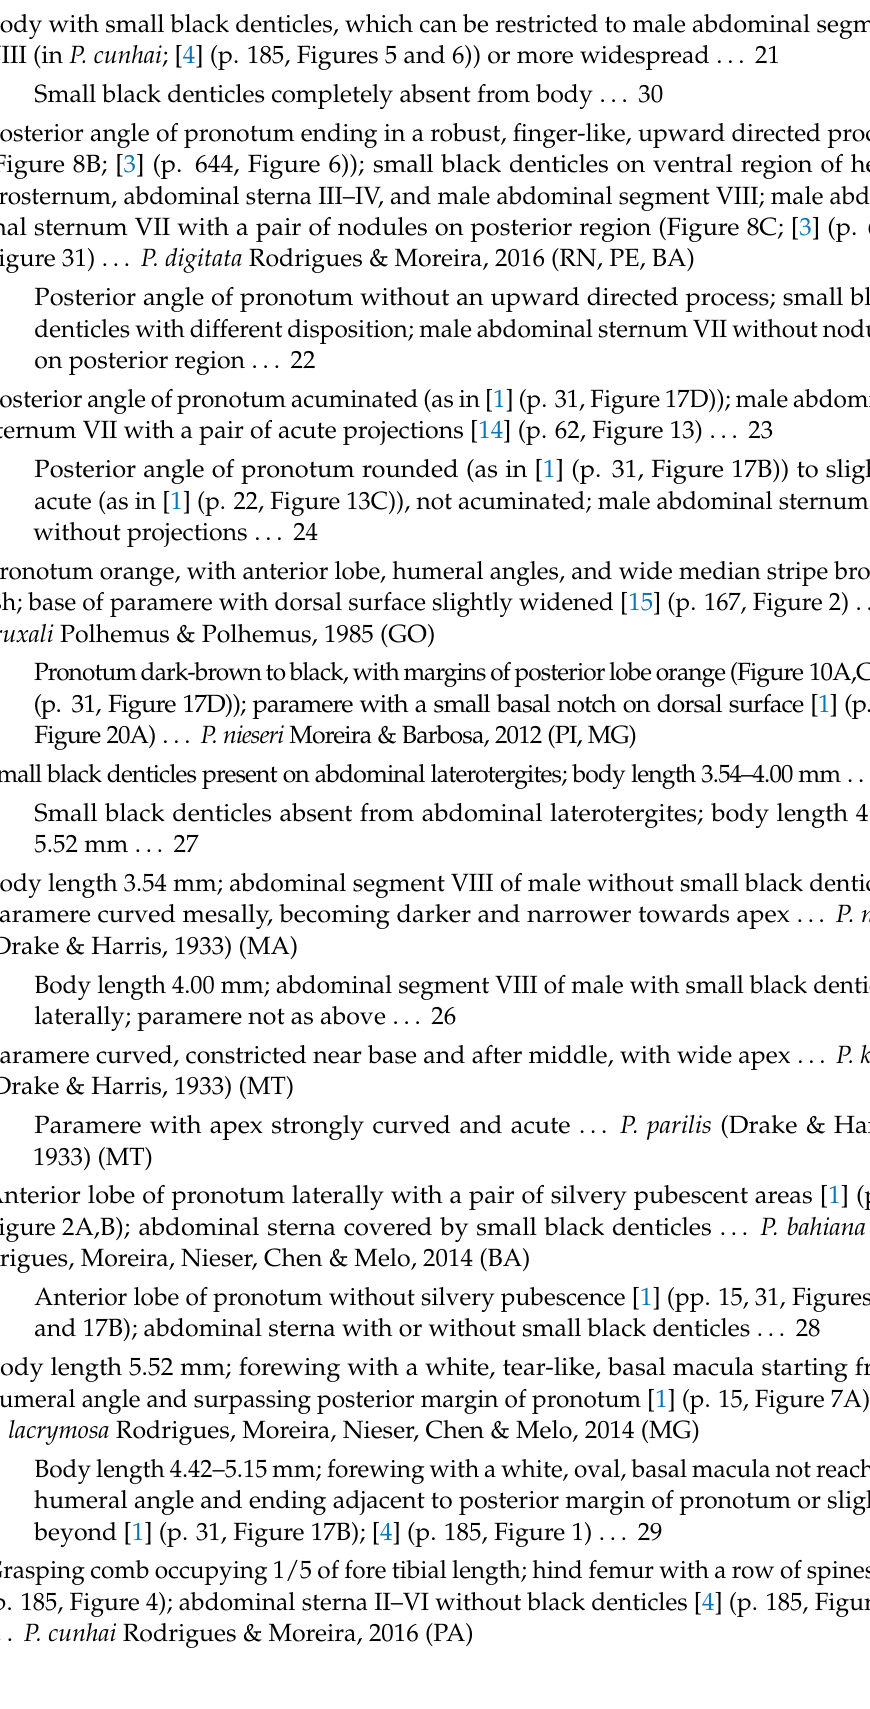
Anterior lobe of pronotum without silvery pubescence [1] (pp. 15, 31, Figures 7A and 17B); abdominal sterna with or without small black denticles . . . 28 humeral angle and surpassing posterior margin of pronotum [1] (p. 15, Figure 7A) . . . Body length 4.42–5.15 mm; forewing with a white, oval, basal macula not reaching humeral angle and ending adjacent to posterior margin of pronotum or